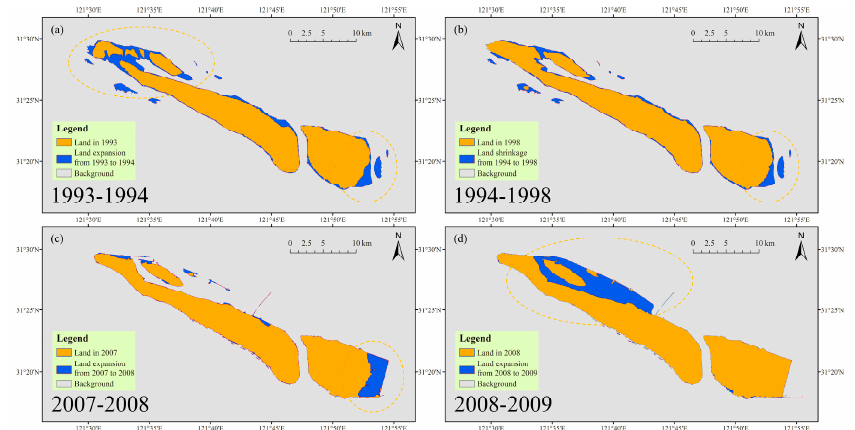
Figure 11. Dramatic changes of estuarine islands during four periods: ( a ) 1993–1994; ( b ) 1994–1998; ( c ) 2007–2008; and ( d ) 2009–2009. Regions within yellow ellipses well present the obvious change of estuarine islands. Background represents the unchanged ocean area during four periods.